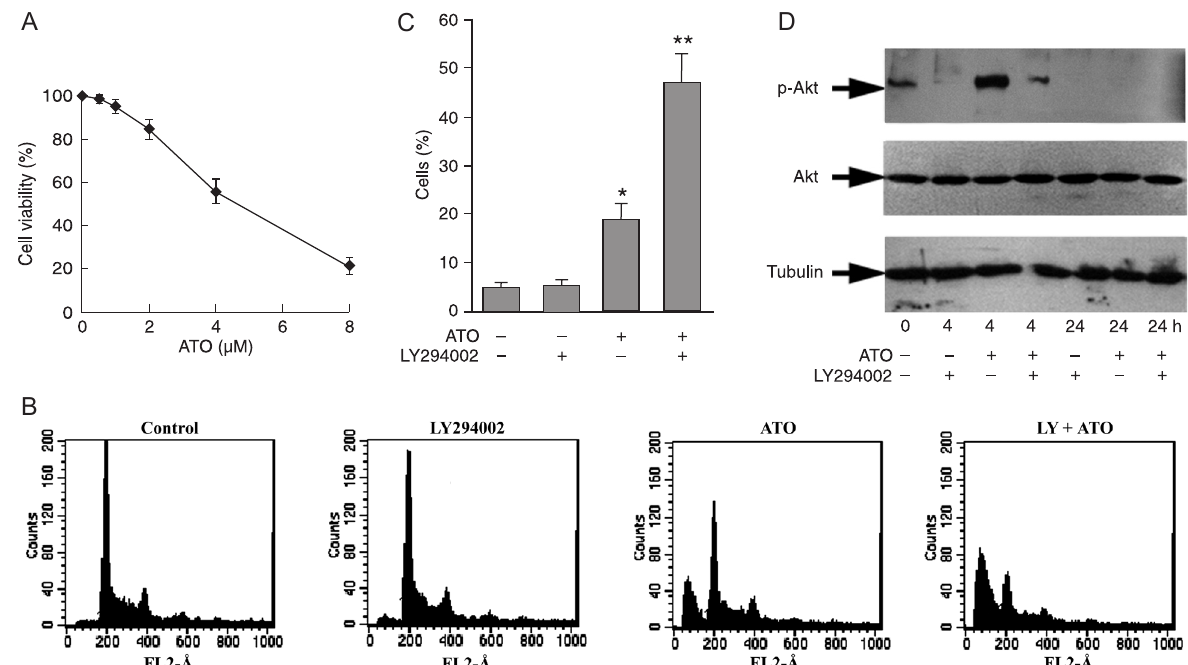
Figure 1. Stimulation of apoptosis by arsenic trioxide (ATO) and phosphatidyl inositol 3 kinase (PI3K)/Akt inhibitors in HL60 cells. A , Cell viability was assessed by the Trypan blue exclusion assay after treatment with ATO for 24 h. B , Frequency of apoptosis in HL60 cell cultures treated for 24 h with 4 μM ATO, either alone or in combination with 25 μM PI3K/Akt inhibitor LY294002. C , Percentage of apoptotic cells in response to ATO and LY294002. D , Total proteins or the proteins in the cytosolic fractions were isolated and phospho- Akt (p-Akt), Akt and β-tubulin levels were measured by Western blotting, as described in the Material and Methods section. The experi - ments were repeated at least three times. Differences between two groups were determined by the Student t -test. *P < 0.05 compared to control cells. **P < 0.05 compared to cells treated with ATO